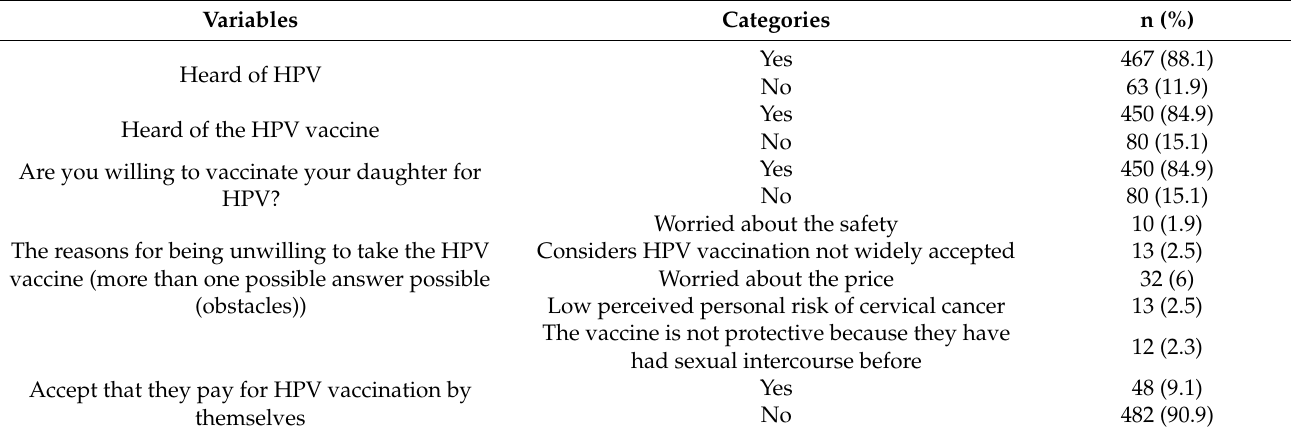
Table 4. Acceptance- and awareness-related questionnaire of the respondents on awareness, accep- tance, and associated factors of human papillomavirus vaccine among parents of daughters in Hadiya zone, southern Ethiopia, 2021 (n = 530).